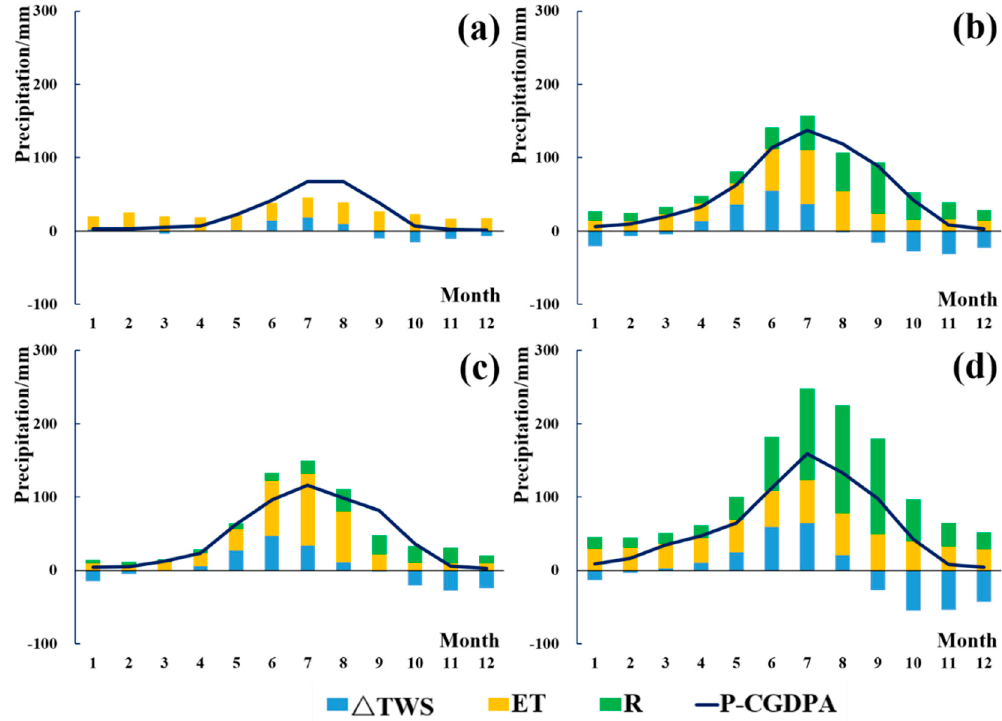
Figure 4. Analysis of monthly precipitation from WBE and CGDPA: ( a ) QT, ( b ) UYA, ( c ) UYE, and ( d ) YZ. The bar represents precipitation from WBE, and the curve represents precipitation from CGDPA. The contribution of each component in the water balance equation is shown in different colors.